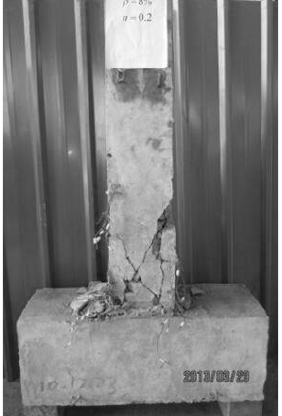
Figure 8. Z2 ( ρ = 8%).